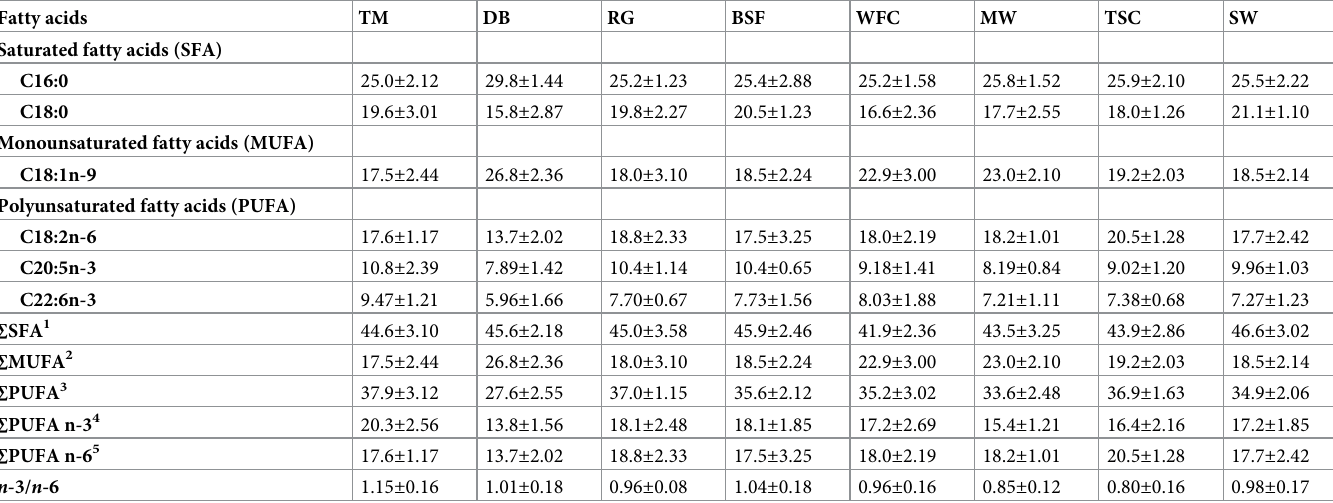
et al. [31] reported that the ADC of MW in L . vannamei was 76.1% for protein, 66.5% for energy, 45.9% for dry matter and 72–86% for AAs showing relatively low values compared to our results. In the present study, DB had the highest protein, lipid and energy ADC in L . van- namei (84–92%, 92% and 87–97%, respectively). Furthermore, lipid ADC of the tested insect meals was relatively higher than those obtained from FM in previous studies [32–34]. The availability of lysine and methionine, the two most limiting AAs in the plant protein sources, Table 10. Fatty acid composition (%, lipid) of muscle of Pacific white shrimp ( Litopenaeus vannamei ) fed the experimental diets for 65 days. Fatty acids TM DB RG BSF WFC MW TSC SW Saturated fatty acids (SFA) C16:0